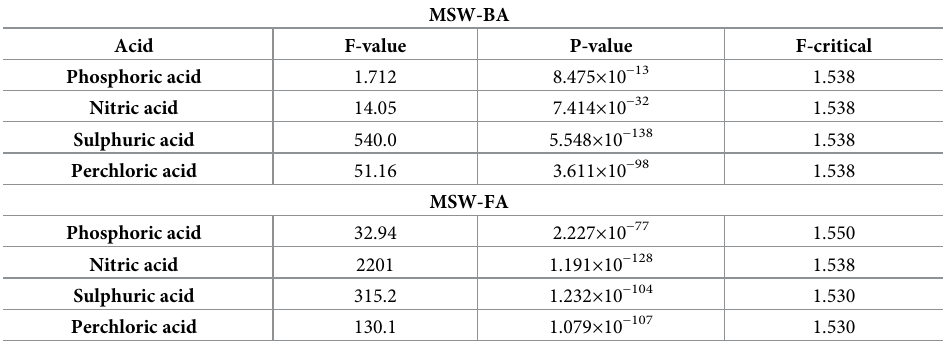
Table 3. Analysis of variance (ANOVA) of the metal extraction for the MSW-BA and the